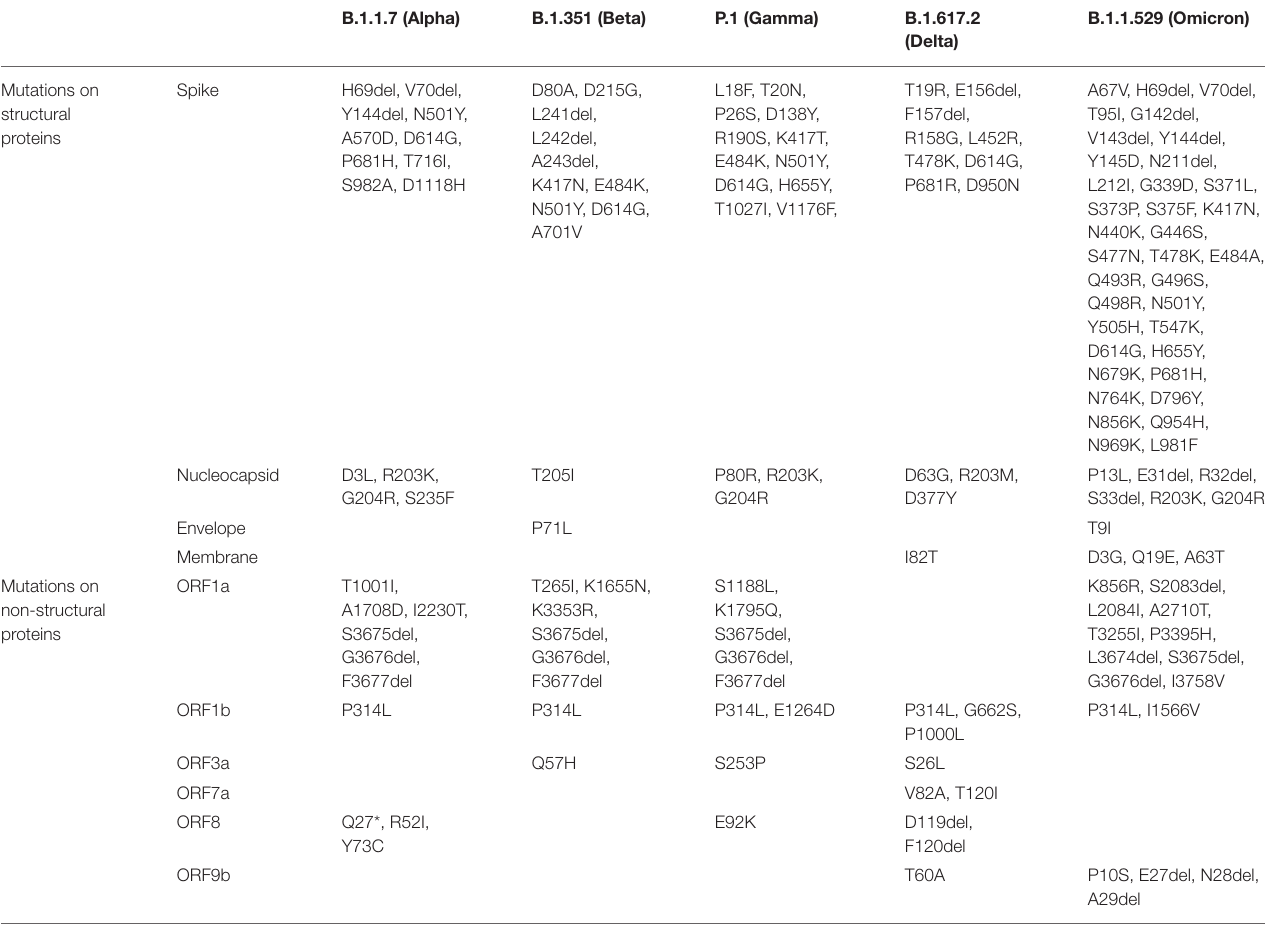
TABLE 3 | Key defining mutations for VOCs